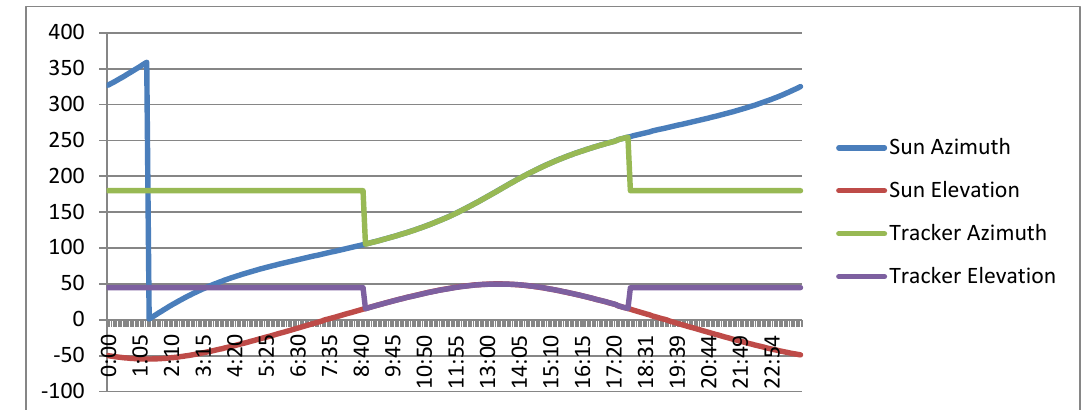
Figure 12. Sun position and tracker pointing (with both elevation and azimuth angles).